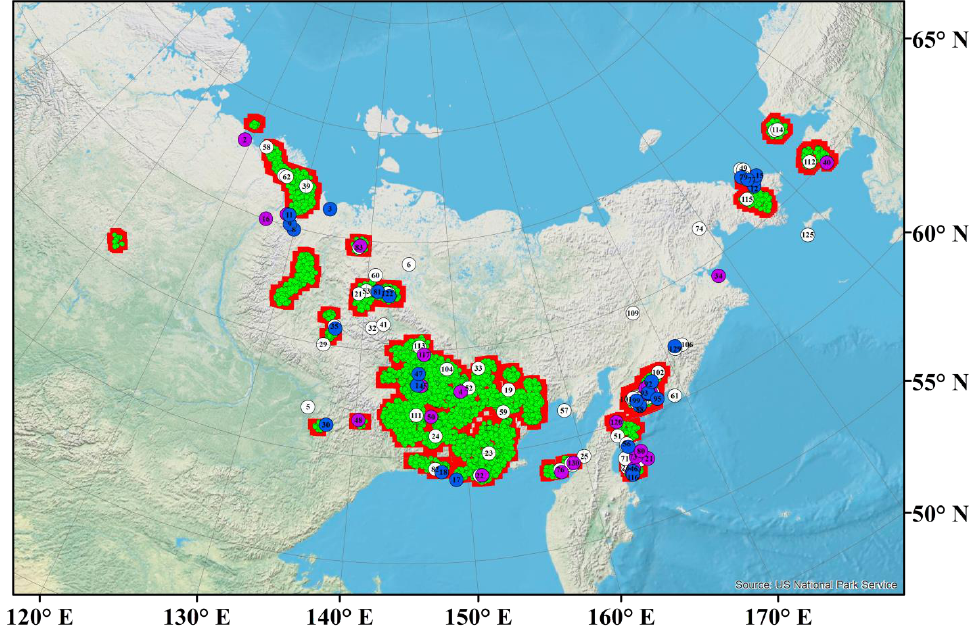
Figure 5. FCAZ zones prone to earthquakes (calculated at M R = 1.5) in the eastern sector of the Russian Arctic and earthquake epicenters with M ≥ 5.0. Designations as in Figure 3.